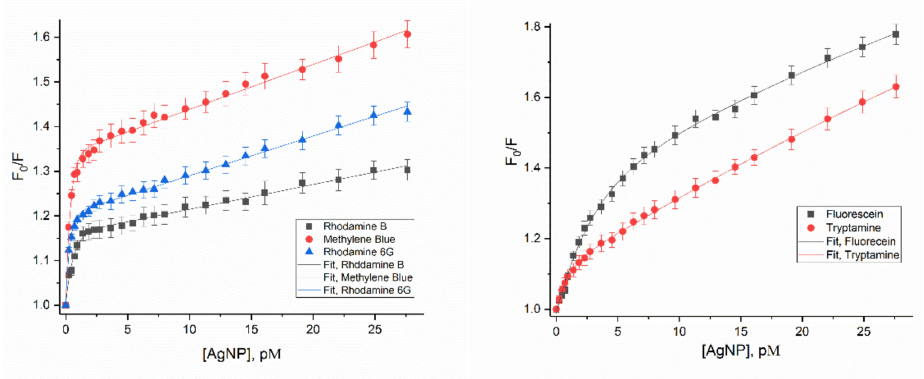
Figure 4. Fit of F 0 / F verse [AgNP] plot of 1 µ M R6G, rhodamine B, methylene blue, fluorescein and